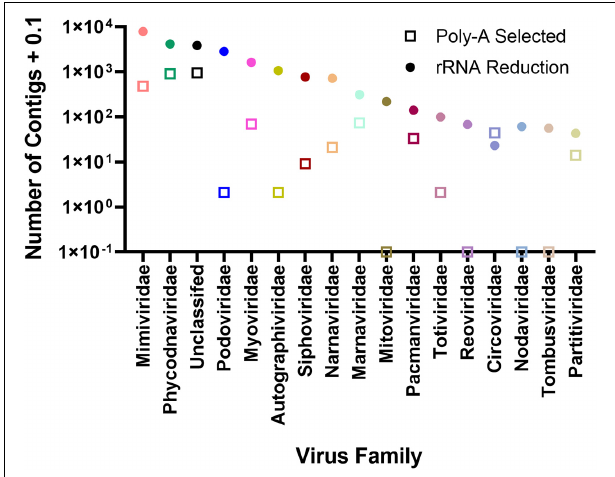
FIGURE 4 | Number of contigs assigned to viral family separated by whether contigs were assembled from rRNA-reduced libraries or poly-A selected